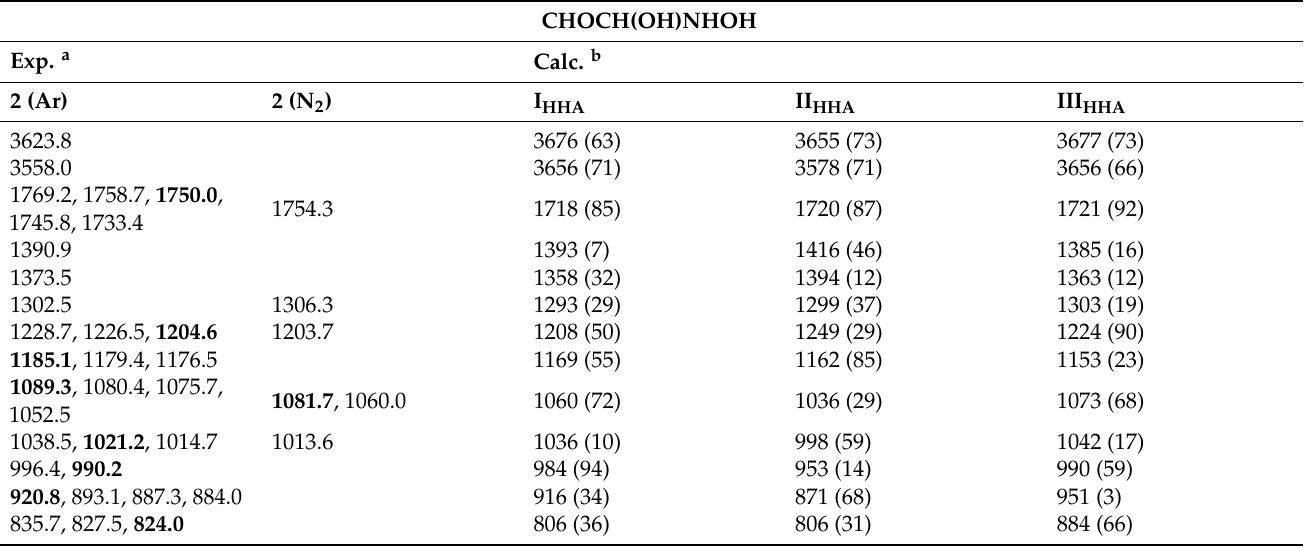
Table 2. Comparison of the observed and calculated anharmonic wavenumbers for